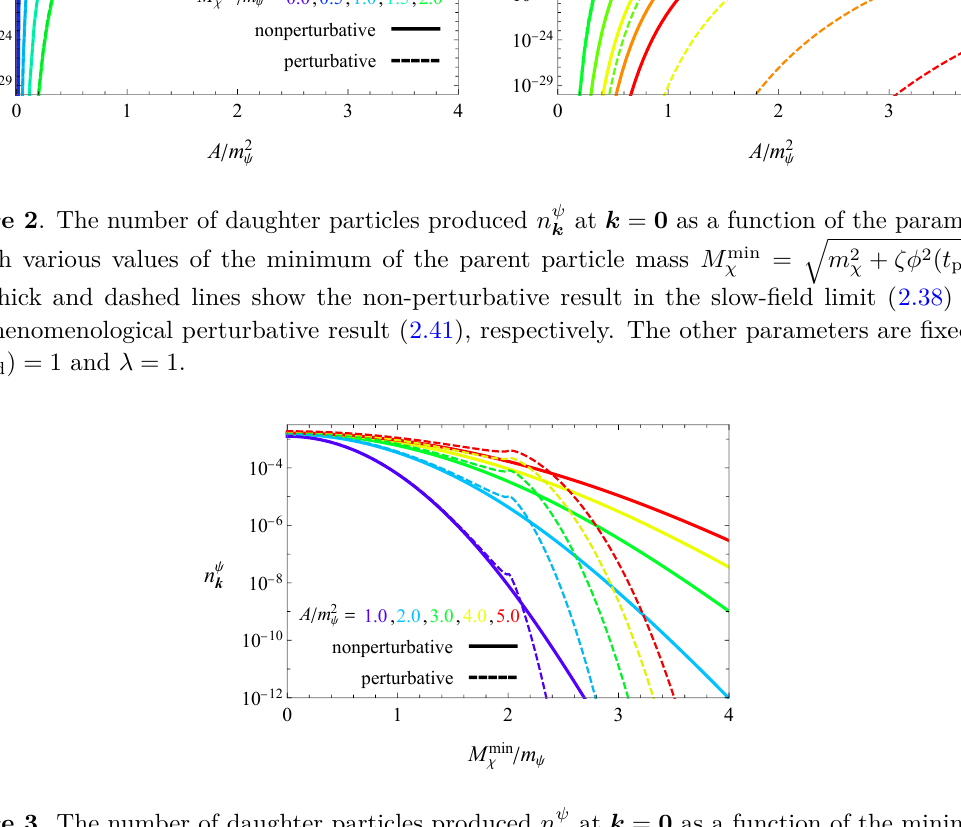
Figure 3 . The number of daughter particles produced n ψ at k = 0 as a function of the minimum k q of the parent particle mass M min = m 2 + ζφ 2 ( t prod ) for various values of A . The thick and χ χ dashed lines show the non-perturbative result in the slow-field limit (2.38) and the phenomenological perturbative result (2.41), respectively. The other parameters are fixed as a ( t prod ) = 1 and λ = 1